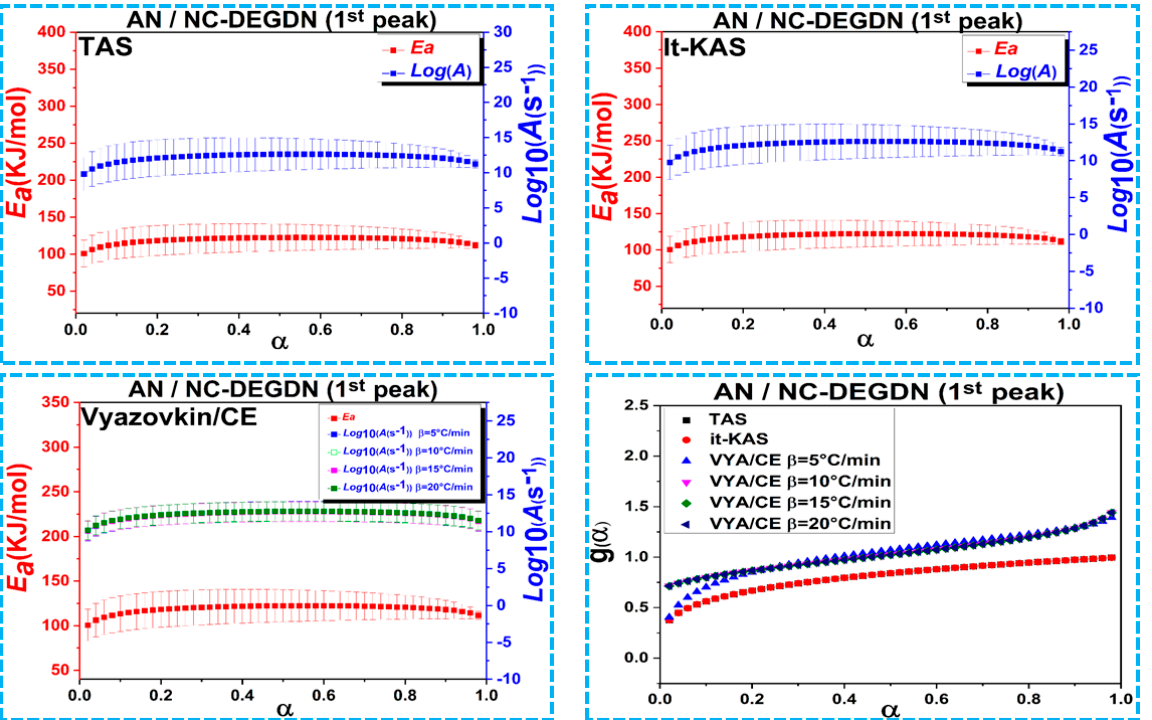
Figure 5. Variation of the kinetic parameters versus conversion for the first thermal decomposition event of AN/NC-DEGDN propellant.